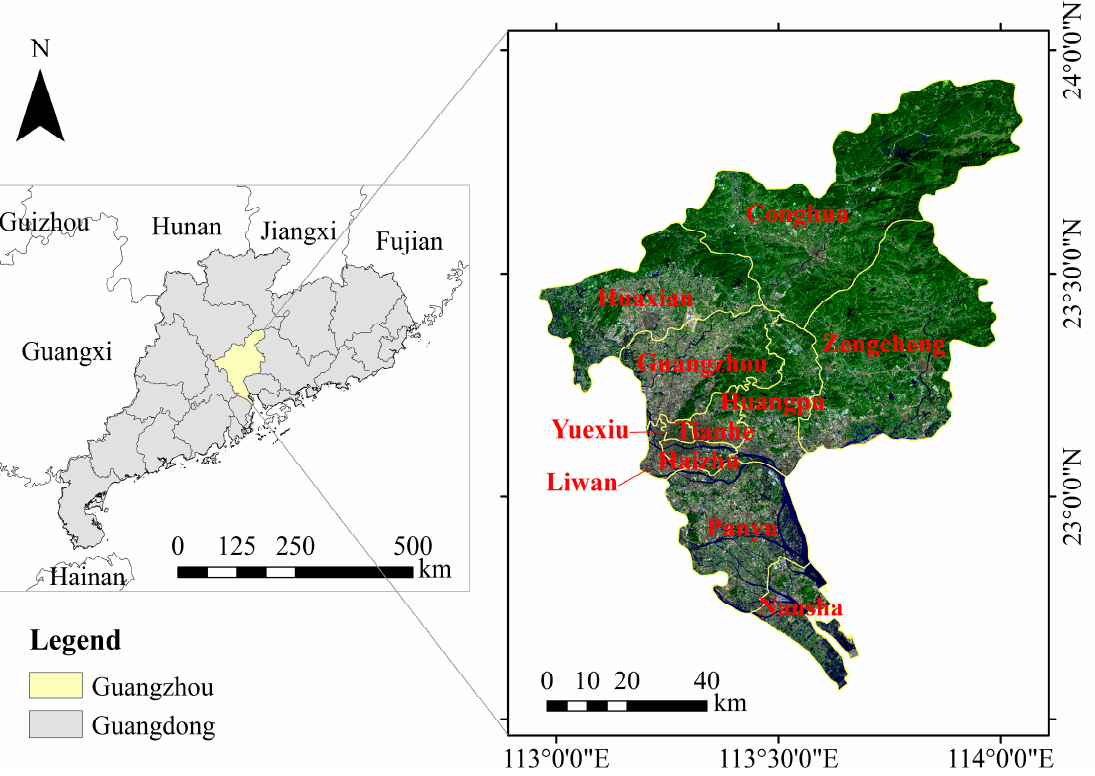
Figure 1. Location of the study area, Guangzhou, China.